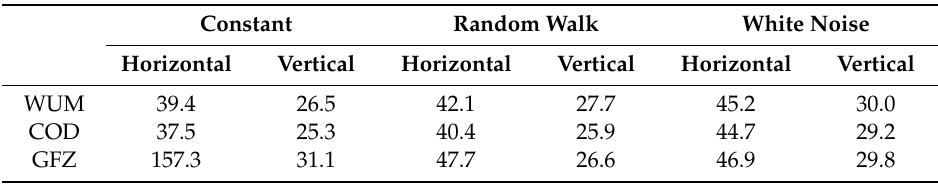
Table 6. Average times (minutes) of GPS/BDS PPP result convergence to 10 cm in horizontal and vertical directions and maintained for one hour among different ISB handling methods with different precise products.